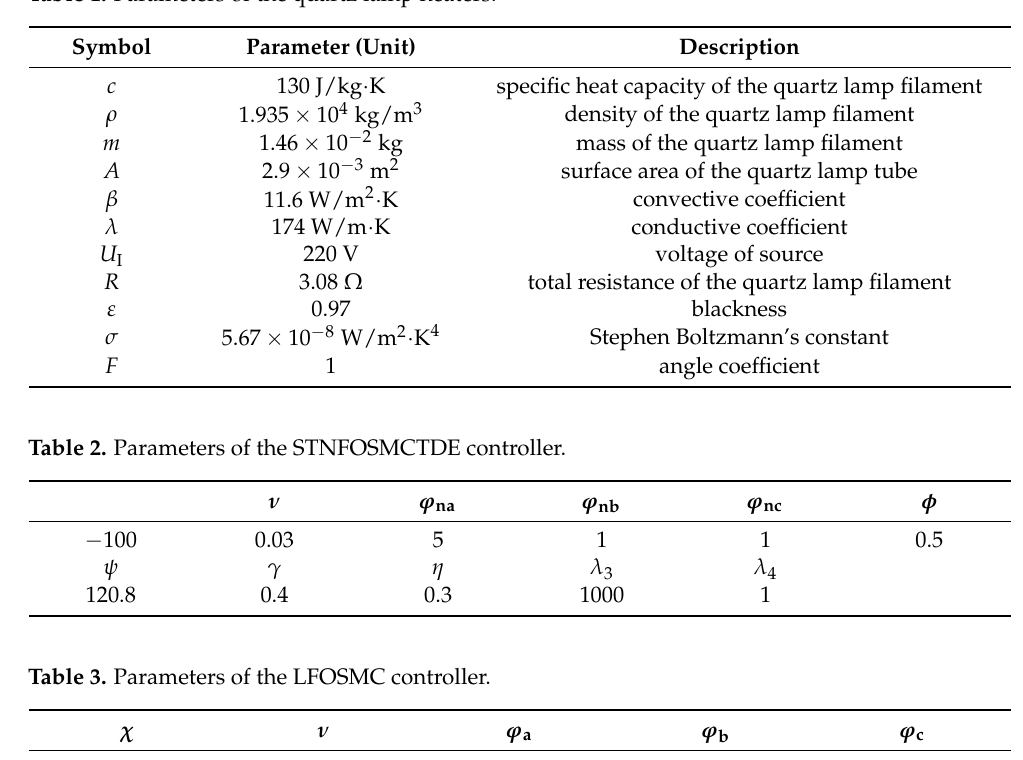
Table 1. Parameters of the quartz lamp heaters.